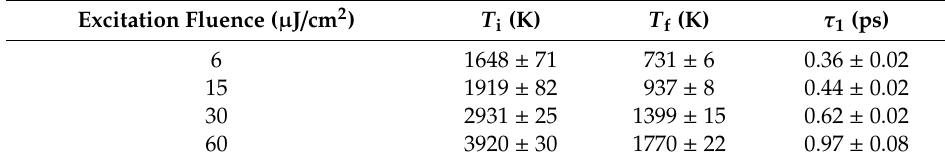
Table 2. Fit parameters for the simulation of charge carrier temperature ( T c ) and the extracted cooling times of thick FAPbI 3 NPs obtained from global analysis at different excitation fluences.